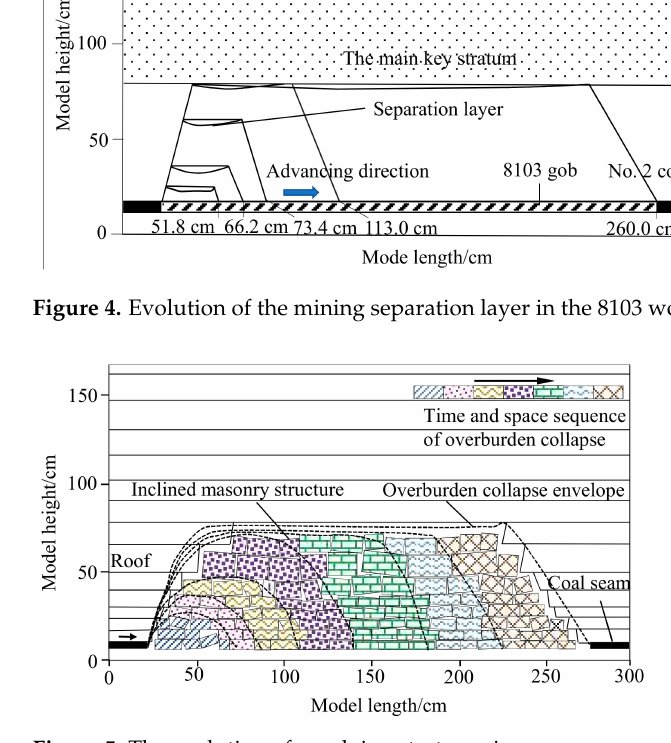
Figure 5. The evolution of overlying strata